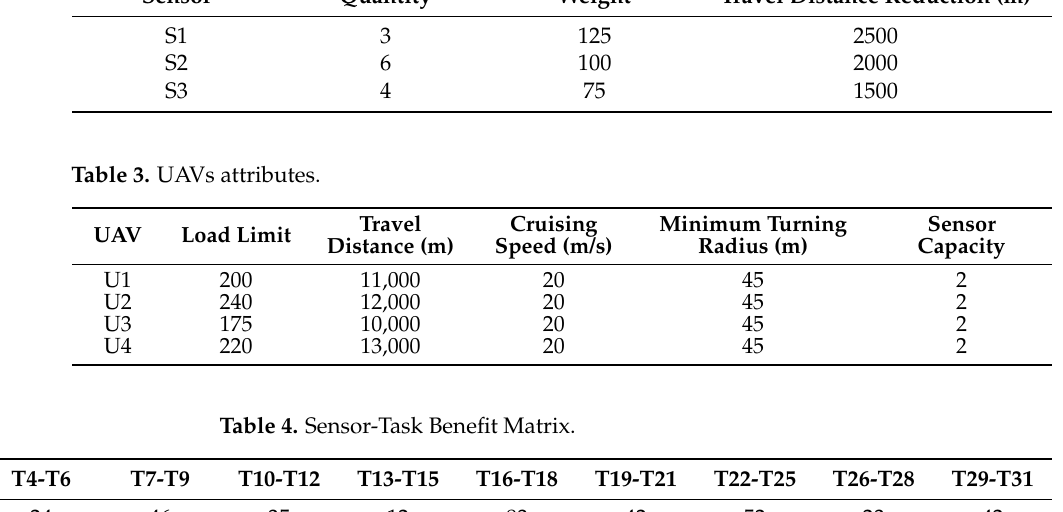
Table 4. Sensor-Task Benefit Matrix. Table 3. UAVs attributes.